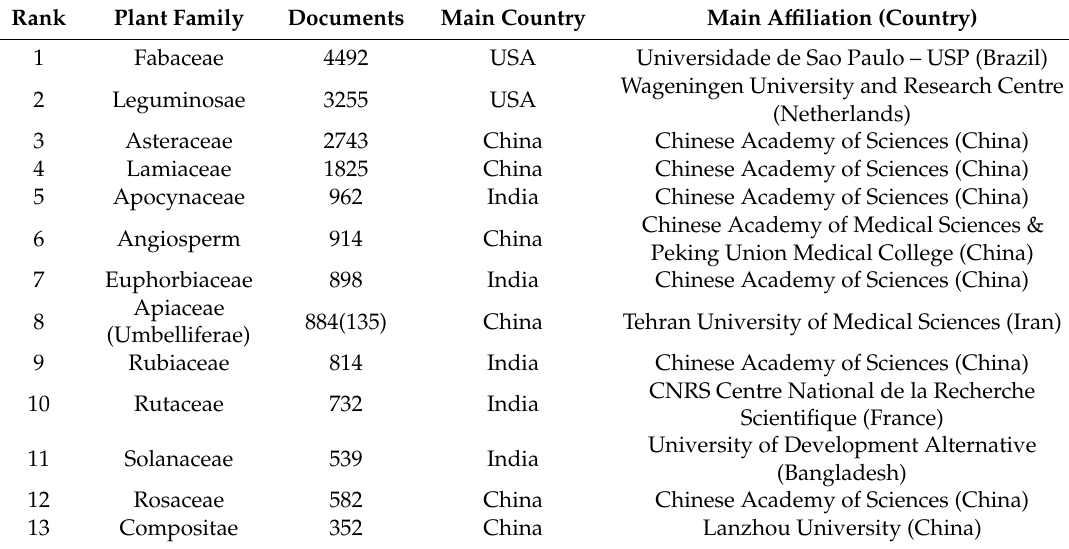
Table 5. Plant families and